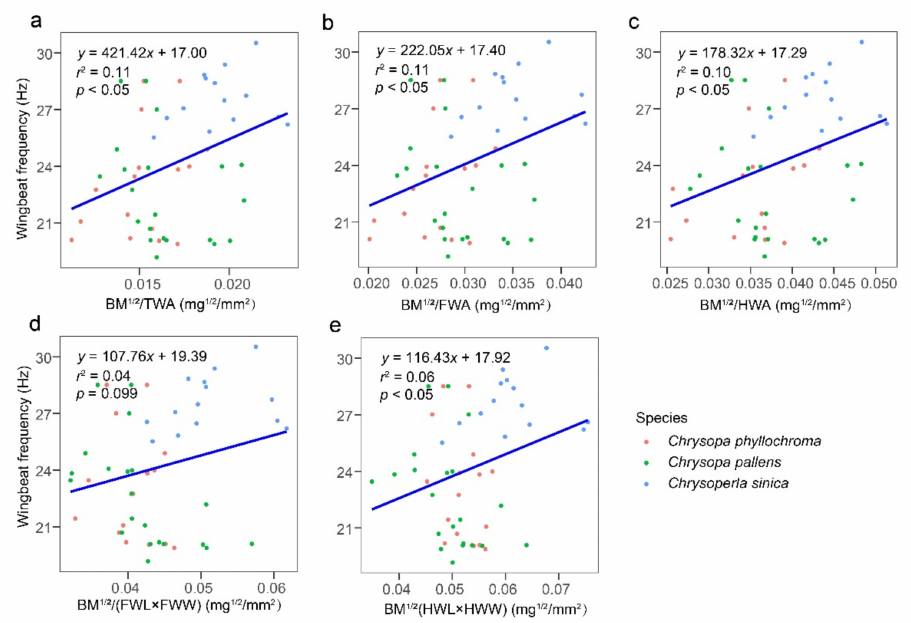
Figure 7. Regression models for wingbeat frequency and morphometrics ( a ) the square root of body mass divided total wing area, ( b ) the square root of body mass divided forewing area, ( c ) the square root of body mass divided hindwing area, ( d ) the square root of body mass divided by the product of forewing length and forewing width, and ( e ) the square root of body mass divided the product of hindwing length and hindwing width, of all test neuropterans. BM, body mass; TM, thoracic mass; AM, abdominal mass; BL, body length; BW, body width; FWL, forewing length; FWW, forewing width; HWL, hindwing length; HWW, hindwing width; FWA, forewing area; HWA, hindwing area; and TWA, total wing area. N = 51 individuals.